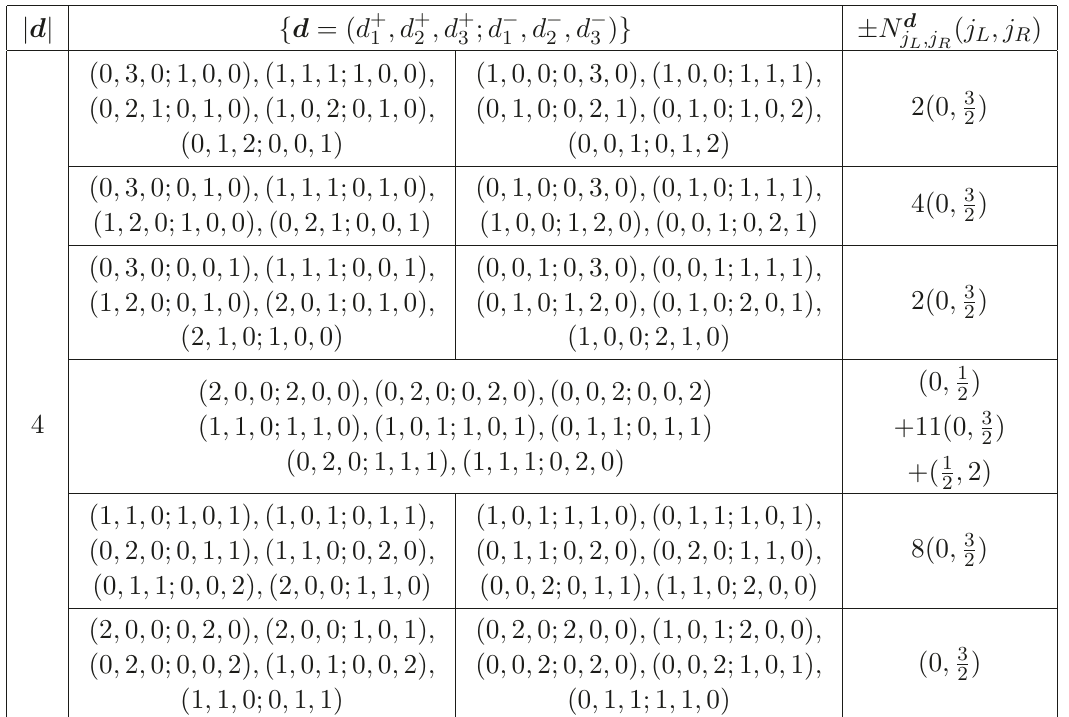
with d = 4 identified for the (2 , 2) model under j L ,j R | | N d ( j L , j R ) on the top of the right j L ,j R ± 1) | d |− −